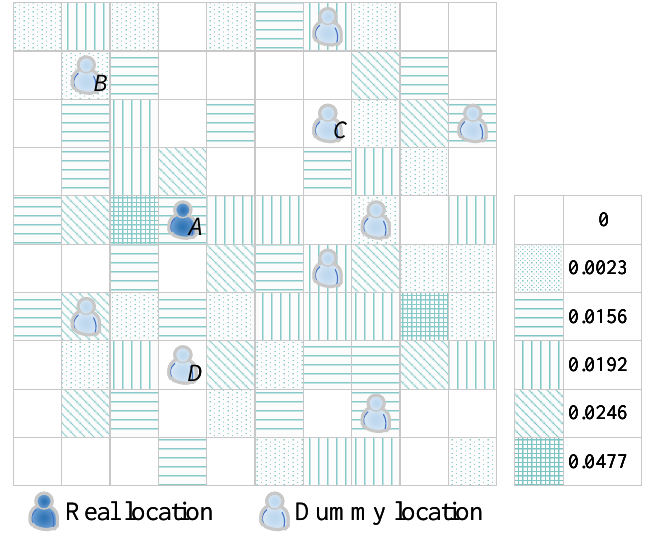
Figure 6. The historical query probability distribution of all